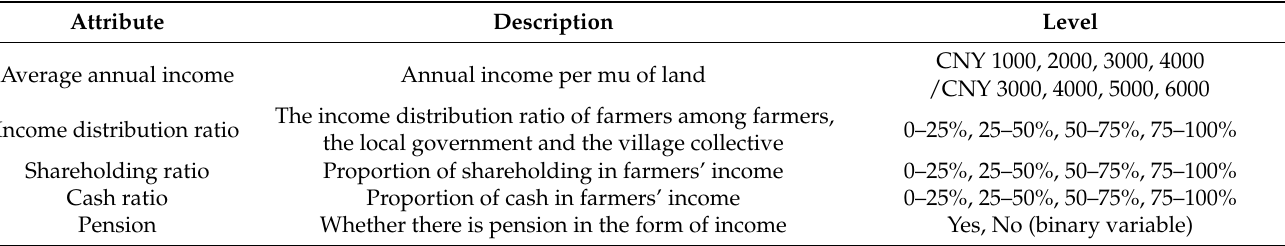
Table 2. Attributes and levels of the